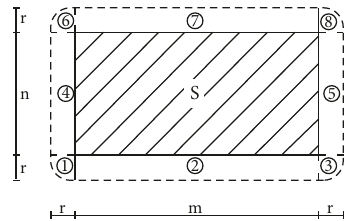
Figure 1: Impact range of an effective antirunway projectile.